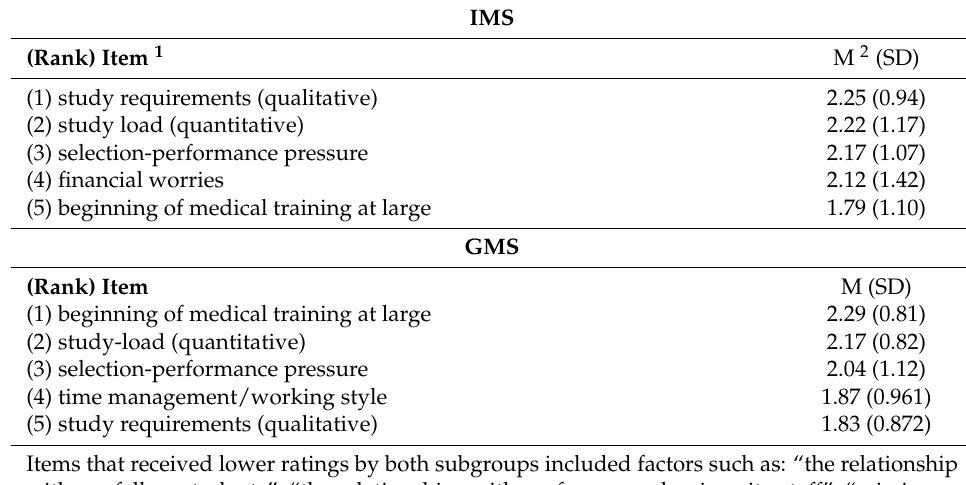
Table 3. Most important specific stressors from the view of IMS vs.